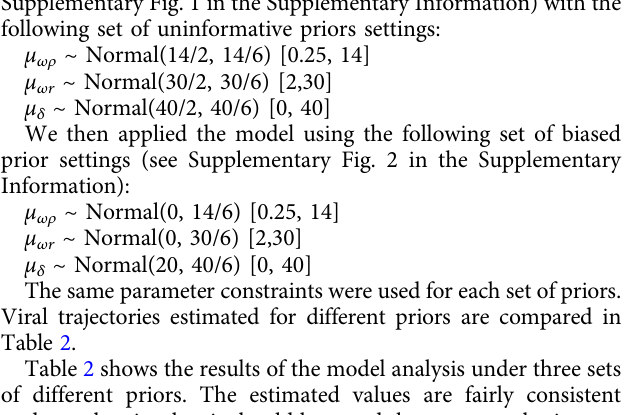
Kinetics of innate immune activation and responses differ among participants . Longitudinal plasma cytokine concentra- tions for participants testing positive for SARS-CoV-2 are shown in Fig. 5. The data are normalized temporally to the day of the fi rst positive SARS-CoV-2 RT-qPCR test result (Day 1). Addi- tionally, related cytokine data are included in Supplementary Fig. 3 in the Supplementary Information, and the complete source dataset is included in Supplementary Data 2. Overall, the cytokine/chemokine concentrations declined from the fi rst day of SARS-CoV-2 RT-qPCR positivity, but the temporal pro fi les varied across participants and cytokines. Interleukin-1 beta (IL-1 β ) and interleukin-1 receptor antagonist (IL-1Ra) plasma concentration timeseries did not follow a consistent trend across participants but appeared to peak around Day 20 prior to declining for two individuals (subjects 21 and 38, Fig. 5A, B). Interleukin-8 and -12 plasma concentrations generally declined over time for all participants (Fig. 5C, D). Concentrations of the chemokine